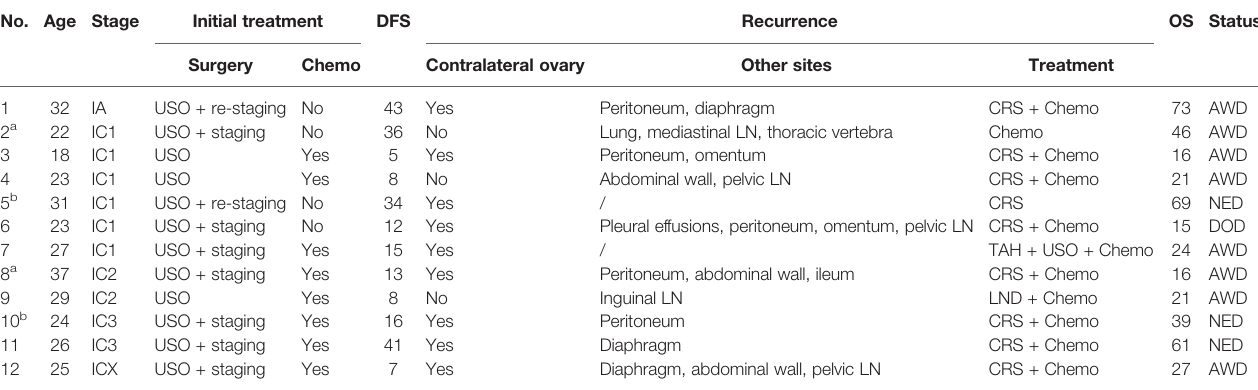
TABLE 3 | Clinical details of the 12 relapsing patients in the FSS group.